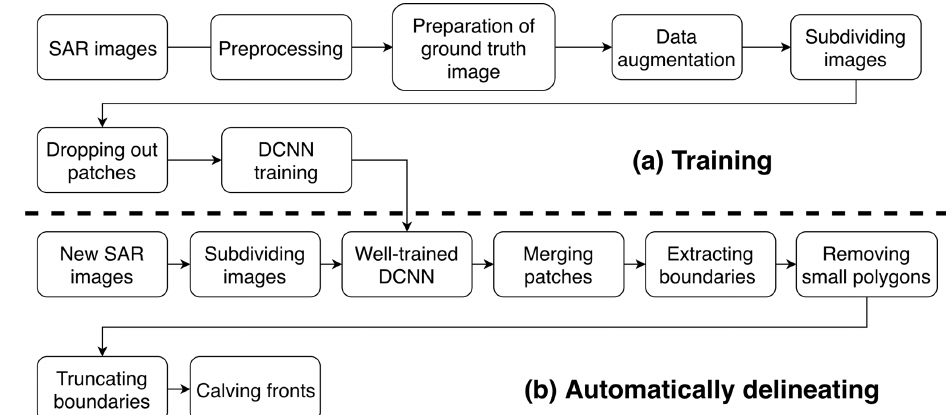
Figure 3. Diagram of the proposed framework. Details are described in Sects. 3 and 4.